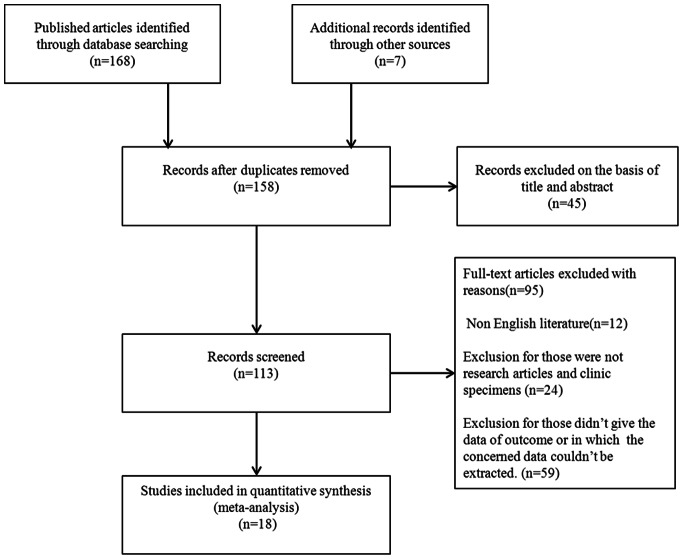
Flow diagram of study selection procedure.